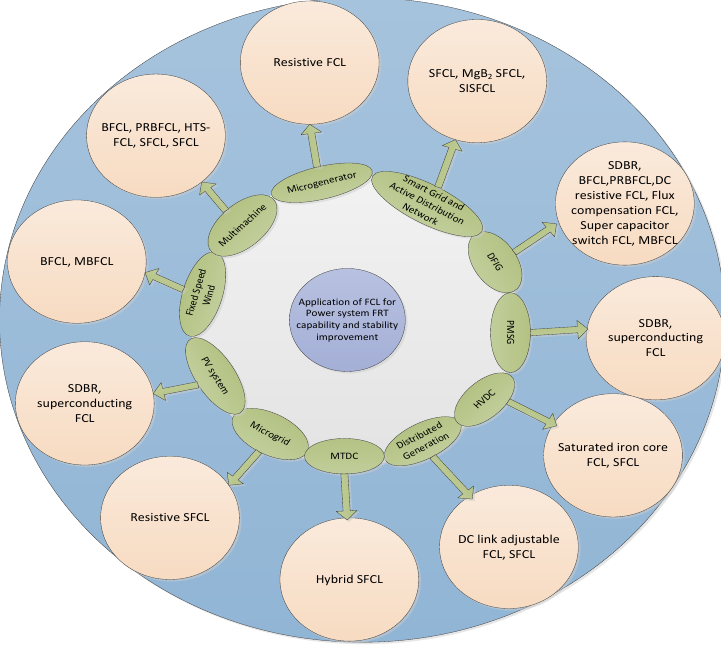
Figure 13. Stability enhancement with fault current limiters.